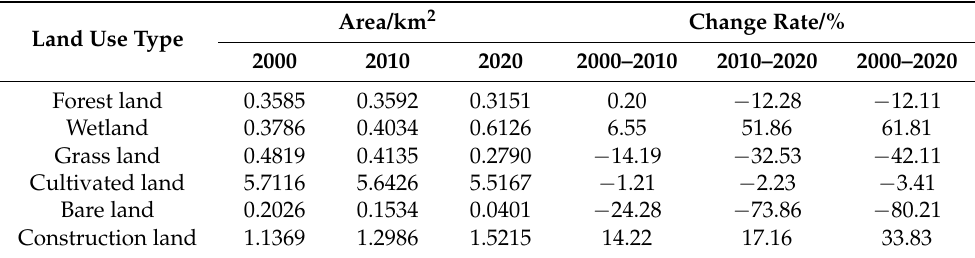
Table 3. Different types of land use area and change rate in typical areas of the Yellow River Basin from 2000 to 2020. Land Use